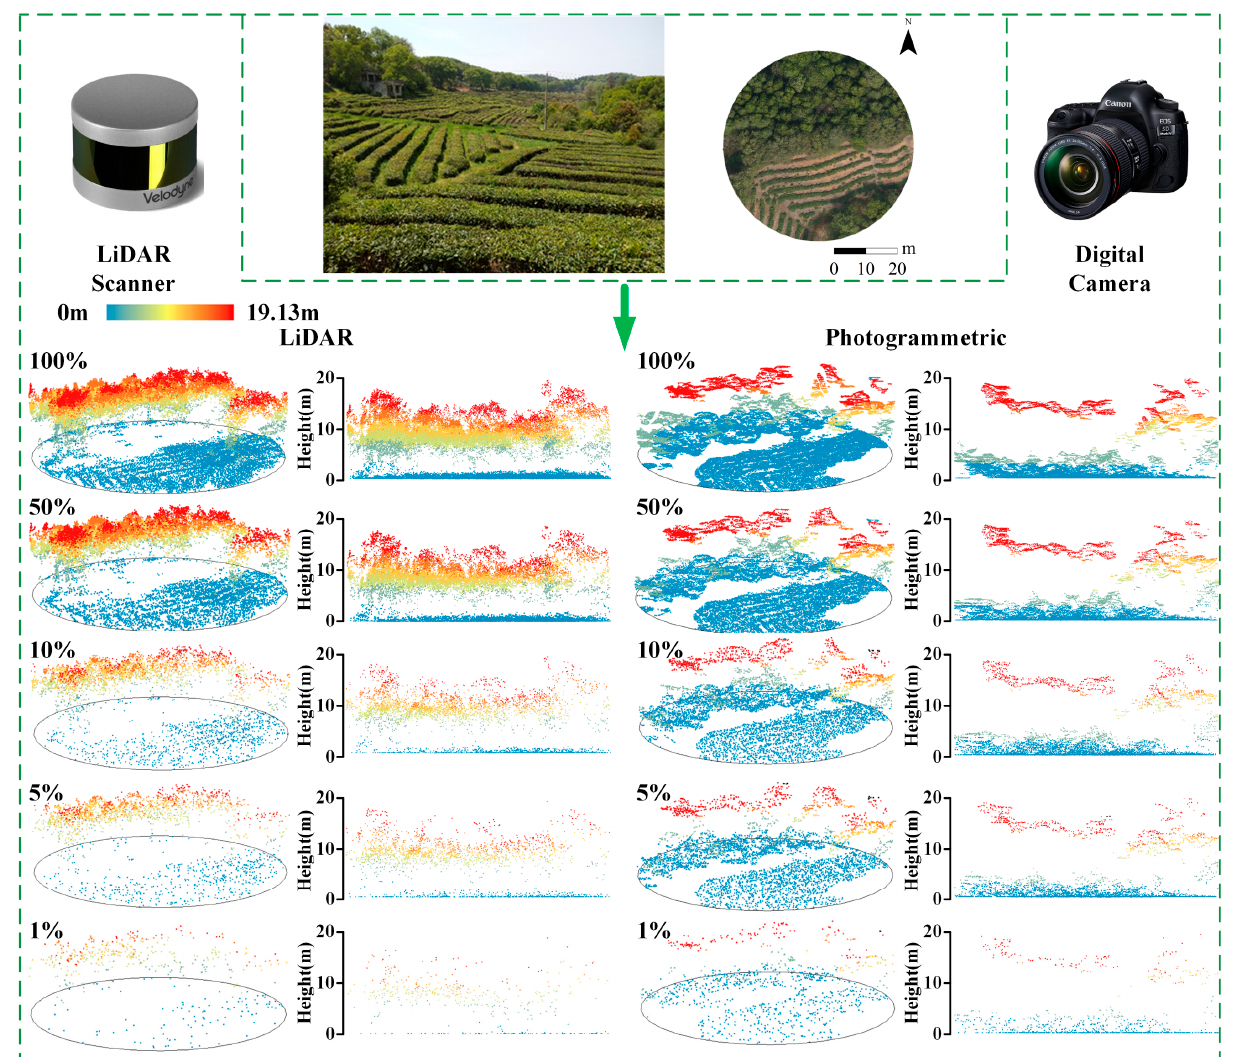
Figure 7. Illustration of percentage-based UAV point cloud data density reduction.